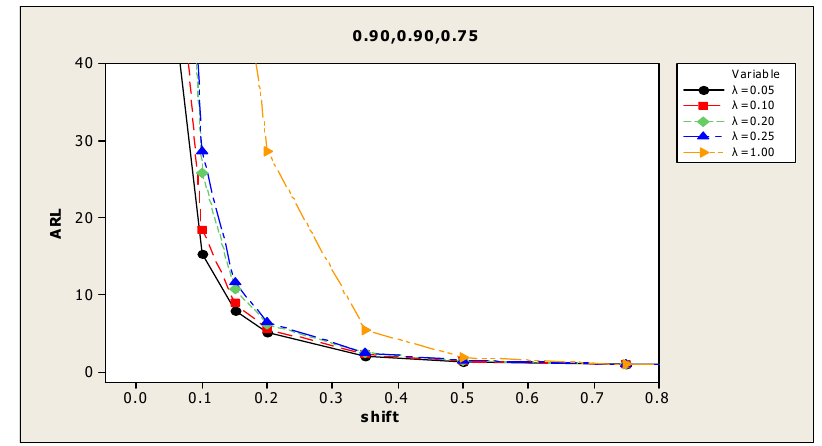
Figure 13. ARL curves when ρ yu = 0.9, ρ yv = 0.9, ρ uv = 0.75 at above values of λ .